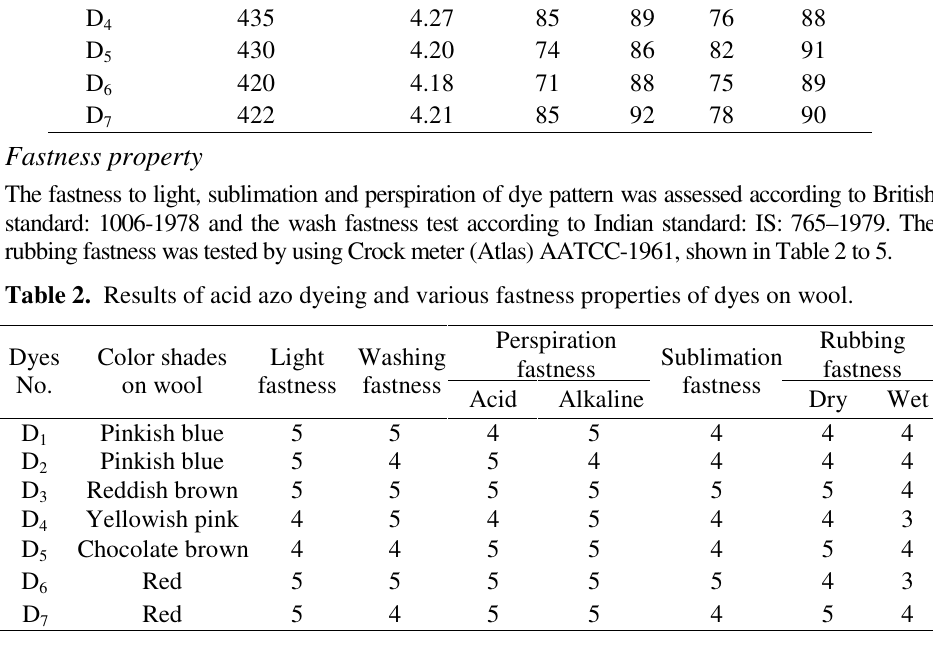
) , intensities (log ε ), exhaustion (E) and fixation (F) of max